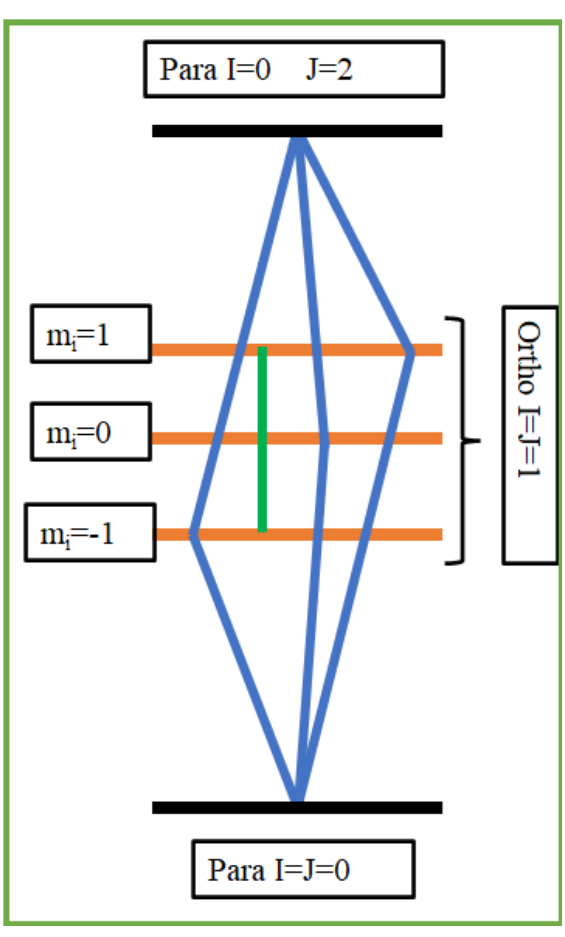
Fig. 15. Hydrogen conversion and nuclear resonance spectroscopy. The ortho manifold is amplified in comparison with the two neighbor para energies. The resonance lines in green are compared to the ortho-para line sin